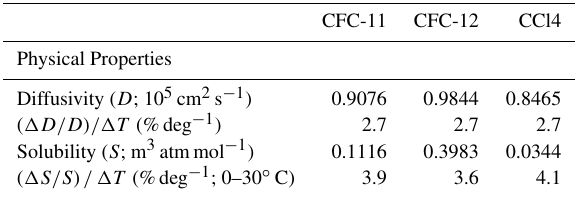
Table 2. Properties of CFC-11, CFC-12 and CCl 4 18.9 ◦